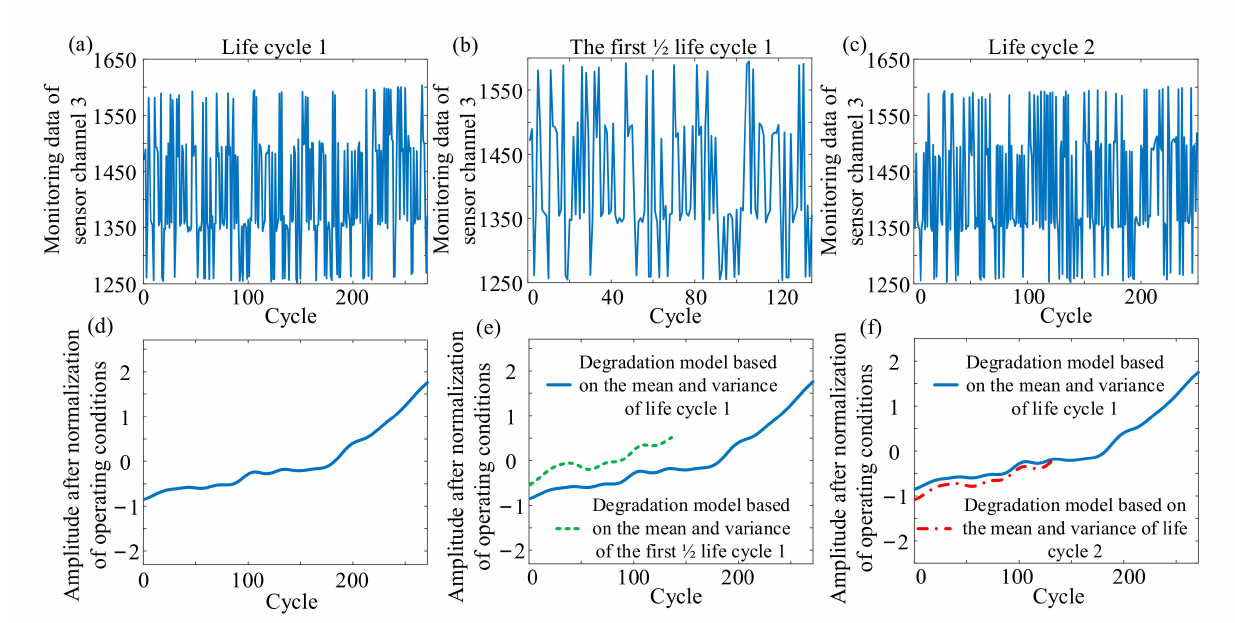
Figure 5. Degradation model comparison based on different mean and variance. ( a ) Life cycle monitoring Data 1 of Sensor Channel 3. ( b ) The first half monitoring Data 1 of Sensor Channel 3. ( c ) Life cycle monitoring Data 2 of Sensor Channel 3. ( d ) Degradation model based on the mean and variance of life cycle monitoring data. ( e ) Degradation model comparison based on the mean and variance of the first half of monitoring Data 1. ( f ) degradation model comparison based on the mean and variance of life cycle monitoring data